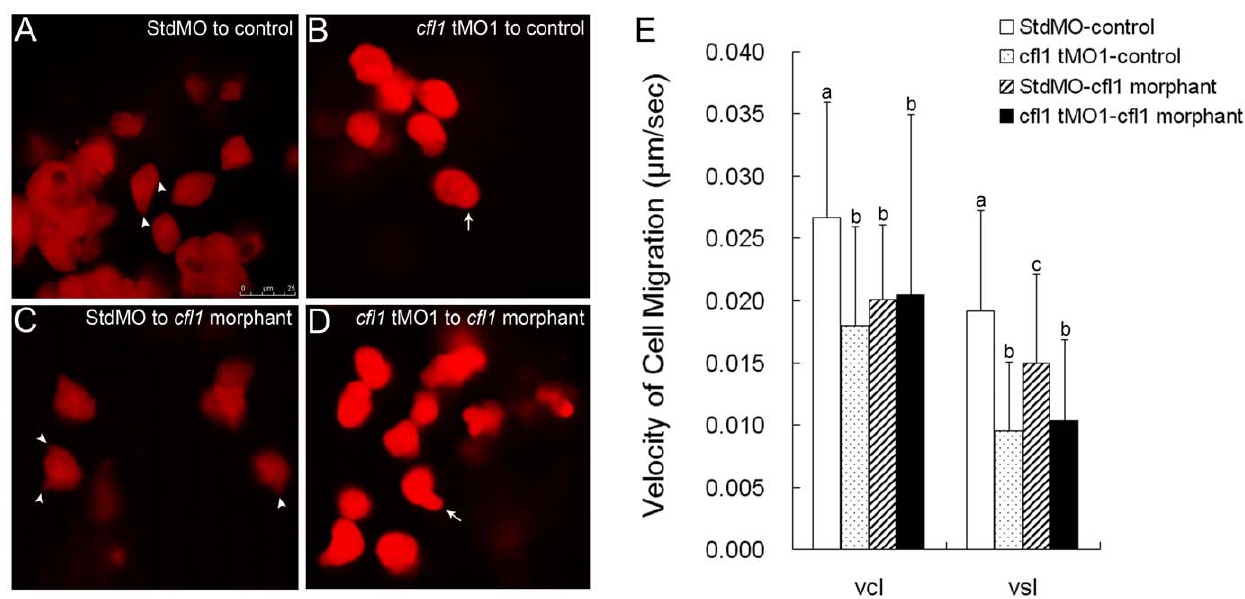
Figure 11. Cfl1 is required cell-autonomously for proper epiboly cell migration. Labeled cells from donor embryos injected with rhodamine-dextran in combined with StdMO ( A, C ) or cfl1 tMO 1 (B, D) were transplanted into control embryos (A, B) and cfl1 morphants (C, D) respectively, and recorded under a confocal microscope. Pseudopods (arrowheads) and polygonal cell shape were observed in StdMO-injected cells transplanted in both control hosts (A) and cfl1 morphants (C), while blebbing-like structure (arrows) and rounded cell shape were observed in cfl1 tMO 1 -injected cells transplanted in both control hosts (B) and cfl1 morphants (D). The photographs shown are representative of at least 10 embryos in each experiment. Migration curvilinear velocity (Vcl) and straight line velocity (Vsl) of these StdMO- and cfl1 tMO 1 -injected cells in control hosts or cfl1 morphants were recorded by time-lapse epifluorescent microscopy and analyzed by SimplePCI software, respectively (E). Values between groups were compared using unpaired Student’s t -test, and those showing a significant (* p , 0.05) difference are denoted by different letters.